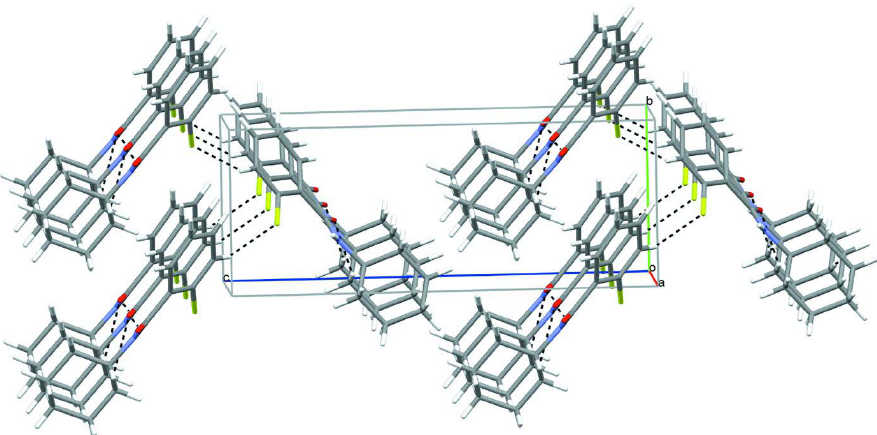
Figure 3 Crystal packing of (I) viewed down the a